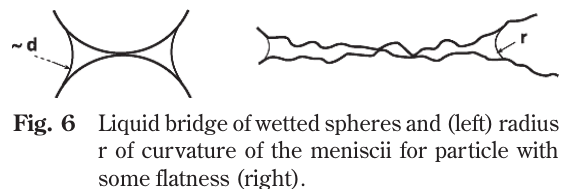
Fig. 6 Liquid bridge of wetted spheres and (left) radius r of curvature of the meniscii for particle with some flatness